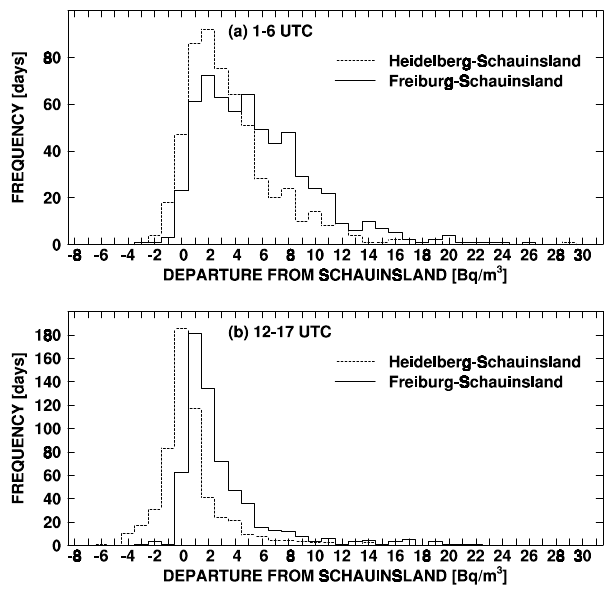
Fig. 2. Frequency distributions of departures of concentrations in Heidelberg and Freiberg from Schauinsland averaged over (a) mid- night to dawn hours (01:00 to 06:00UTC) and (b) afternoon hours (12:00 to 17:00UTC); solid line for Freiburg minus Schauinsland, dashed line for Heidelberg minus